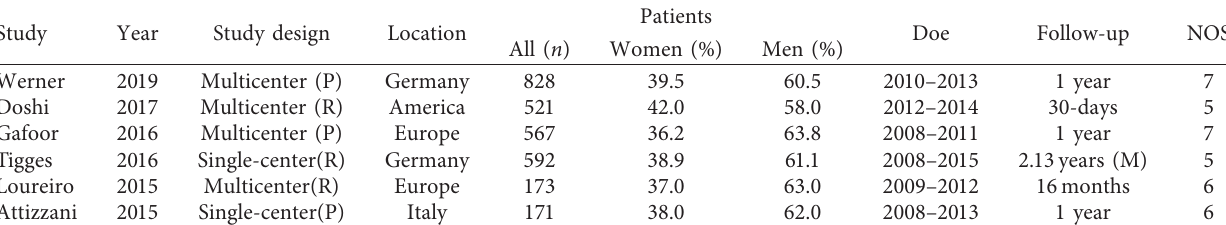
Table 1: Characteristics of included MC